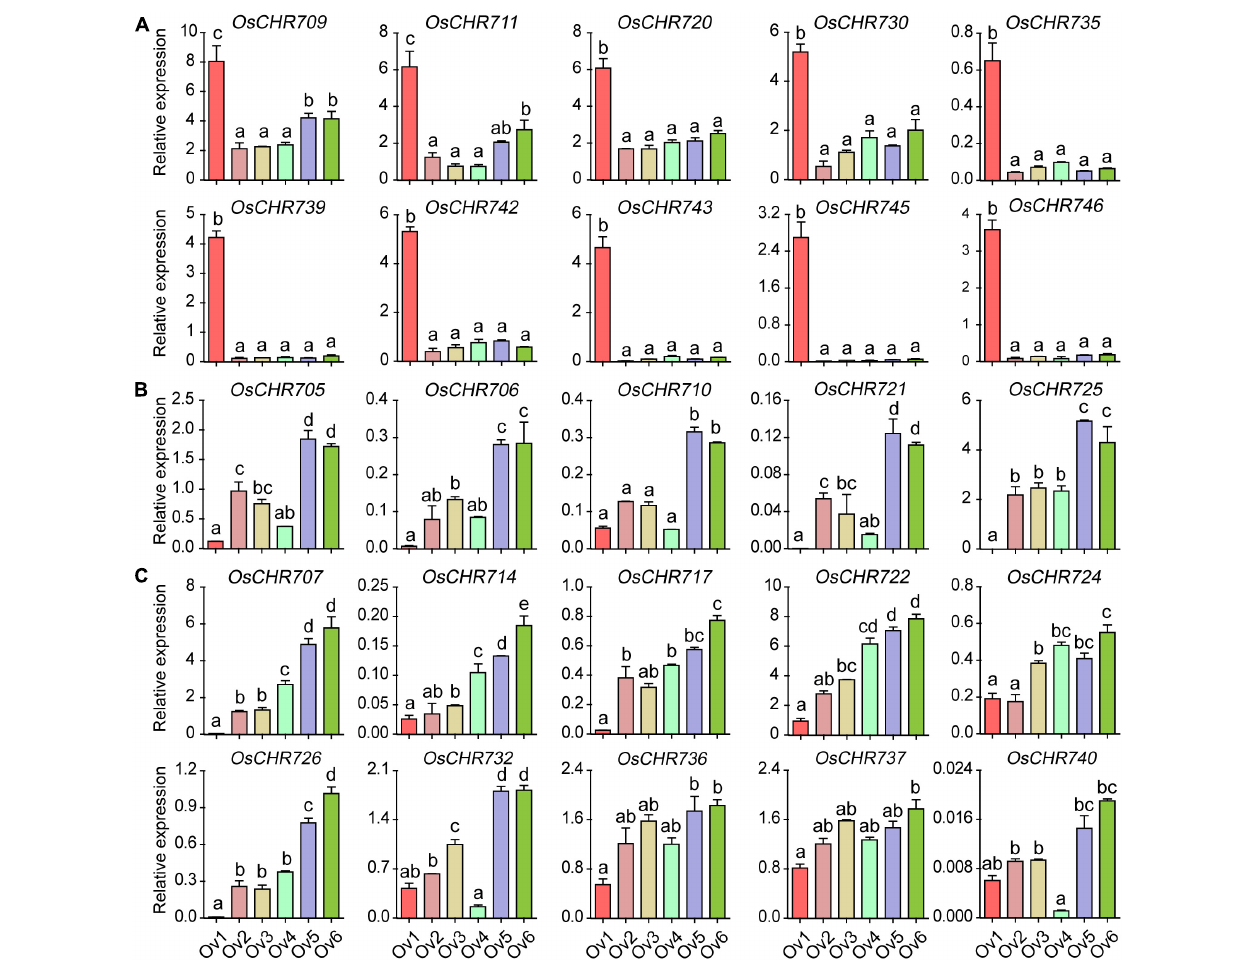
FIGURE 3 | The relative expression level of Snf2 gene family in the ovary. (A) Specifically expressed Snf2 genes at the early developmental stages (Ov1) in the ovary. (B) Predominantly expressed Snf2 genes at the late developmental stages (Ov5 and Ov6) in the ovary. (C) The expression level of Snf2 gene gradually escalated from early to late developmental stages in the ovary. Ov1-5, the ovary of 2–3, 3–4, 4–5, 5–6, and 6–7 mm spikelet, respectively; Ov6, the ovary in the spikelet before pollination. The y -axis is the relative expression level of the gene compared to OsUBQ5 in different developmental stages of the ovary using the qRT-PCR. The relative expression level of OsCHR701 to OsUBQ5 in An1 stage normalized as “1” was used as reference. Error bars indicate standard deviations of independent biological replicates ( n = 3). Different letters denote significant differences at P < 0.05 according to ANOVA in combination with Duncan’s multiple range